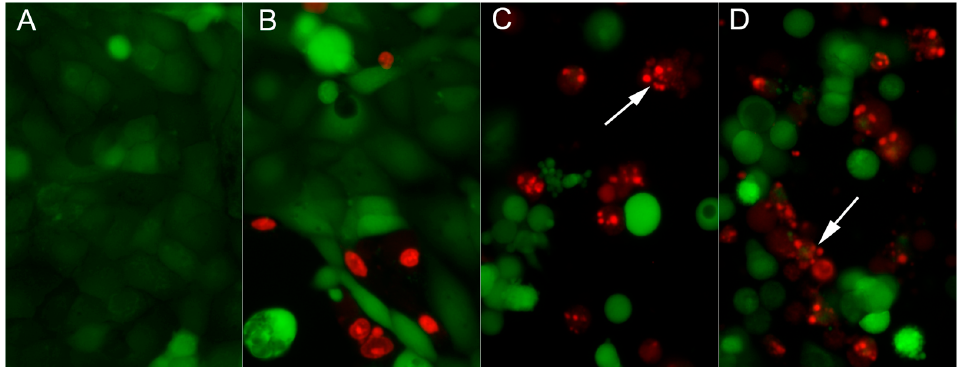
Figure 12. Live/Dead staining of DU145 cells cultured for 24 h in the presence of nanofibers; ( A ) control; ( B ) drug-free patches; ( C ) CTX- loaded patches; ( D ) 10 nM CBT solution; arrows indicate late apoptotic cells; magnification ×200.